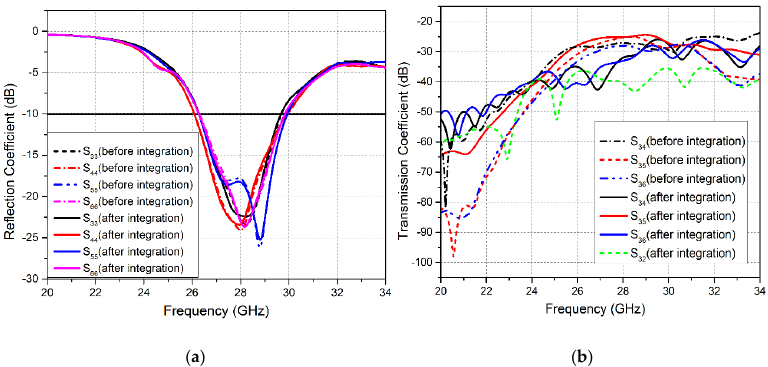
Figure 6. Simulated S-parameter Curves for 5G MIMO Antennas Before and After Integration ( a ) Reflection Coefficient; ( b ) Transmission Coefficient. ( a ) Reflection Coe ffi cient; ( b ) Transmission Coe ffi cient.